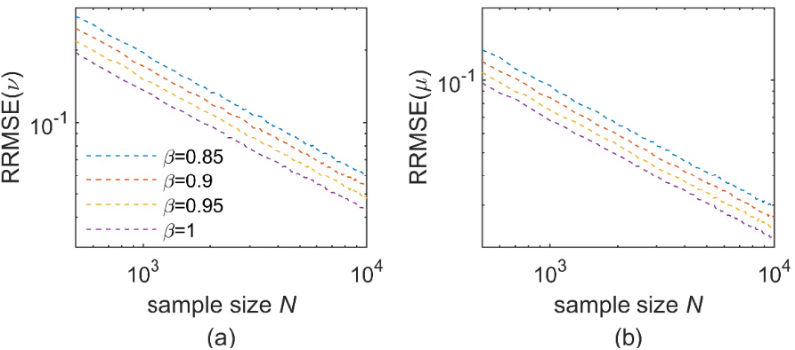
Figure 2. Performance comparison of the TML estimation methods with β = 0.85, 0.9, and 0.95 and 1 in the case without outliers: ( a ) RRMSEs of the inverse shape parameter, ( b ) RRMSEs of the scale parameter.